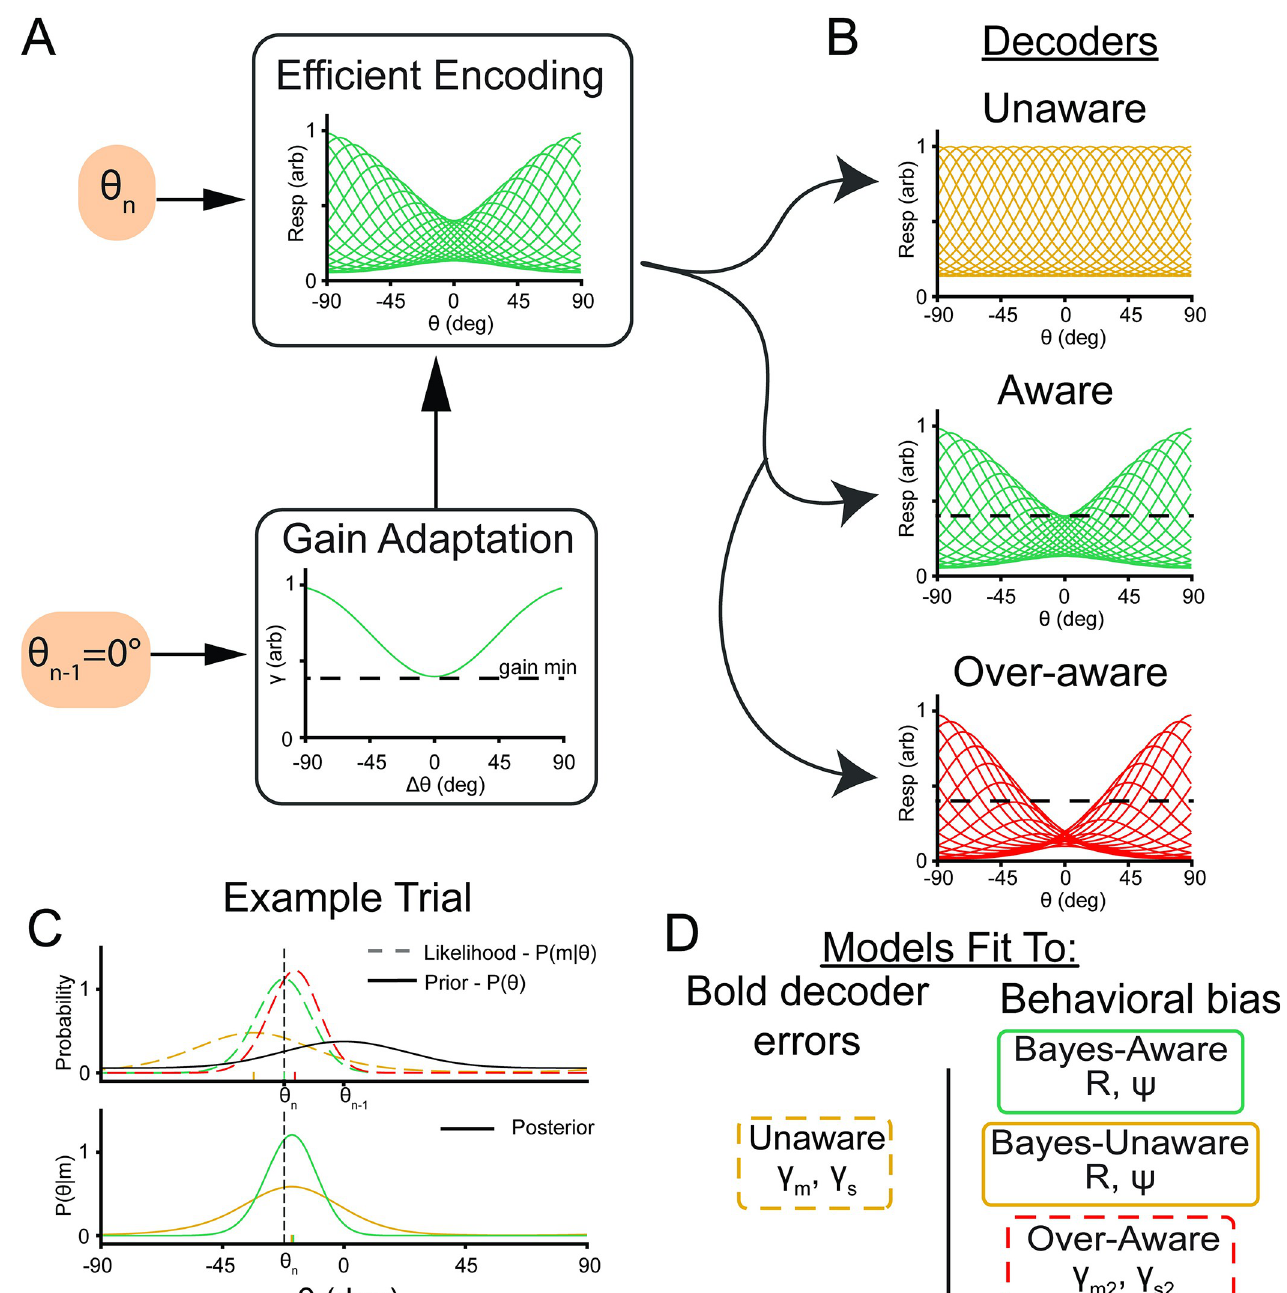
Fig 4. Encoder–decoder model schematic. (A) Encoding. Units with von Mises tuning curves encodes incoming stimuli. The gain of individual units undergoes adaptation such that their activity is reduced as a function of their distance from the previous stimulus. (B) Decoding. This activity is then read out using a scheme that assumes 1 of 3 adaptation profiles. The unaware decoder assumes no adaptation has taken place, the aware decoder assumes the true amount of adaptation while the overaware decoder overestimates the amount of adaptation (note center tuning curves dip lower than the minimum gain line from encoding). (C) Example stimulus decoding. Top: The resulting likelihood function for the unaware readout (dotted yellow line) has its representation for the current trial ( θ n = − 30˚) biased away from the previous stimulus ( θ n-1 = 0˚). The aware readout (dotted green line) is not biased, while the overaware readout is biased toward the previous stimulus. These likelihood functions can be multiplied by a prior of stimulus contiguity (solid black line) to get a Bayesian posterior (bottom) where Bayes-unaware and Bayes-aware representations are shifted toward the previous stimulus. Tick marks indicate maximum likelihood or decoded orientation. (D) Summary of models and free parameters being fit to both BOLD decoder errors and behavioral bias. Data and code supporting this figure found here: https://osf.io/e5xw8/?view_only=e7c1da85aa684cc8830aec8d74afdcb4.